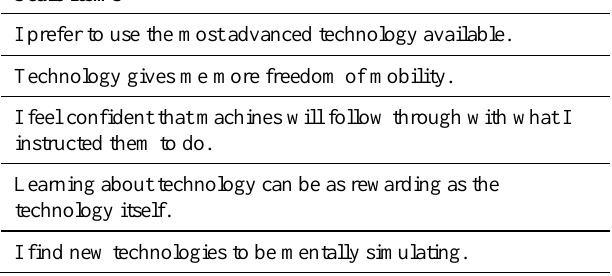
Table 2: Description of the measurement scale used to measure optimism from the TRI Optimism sub- dimension